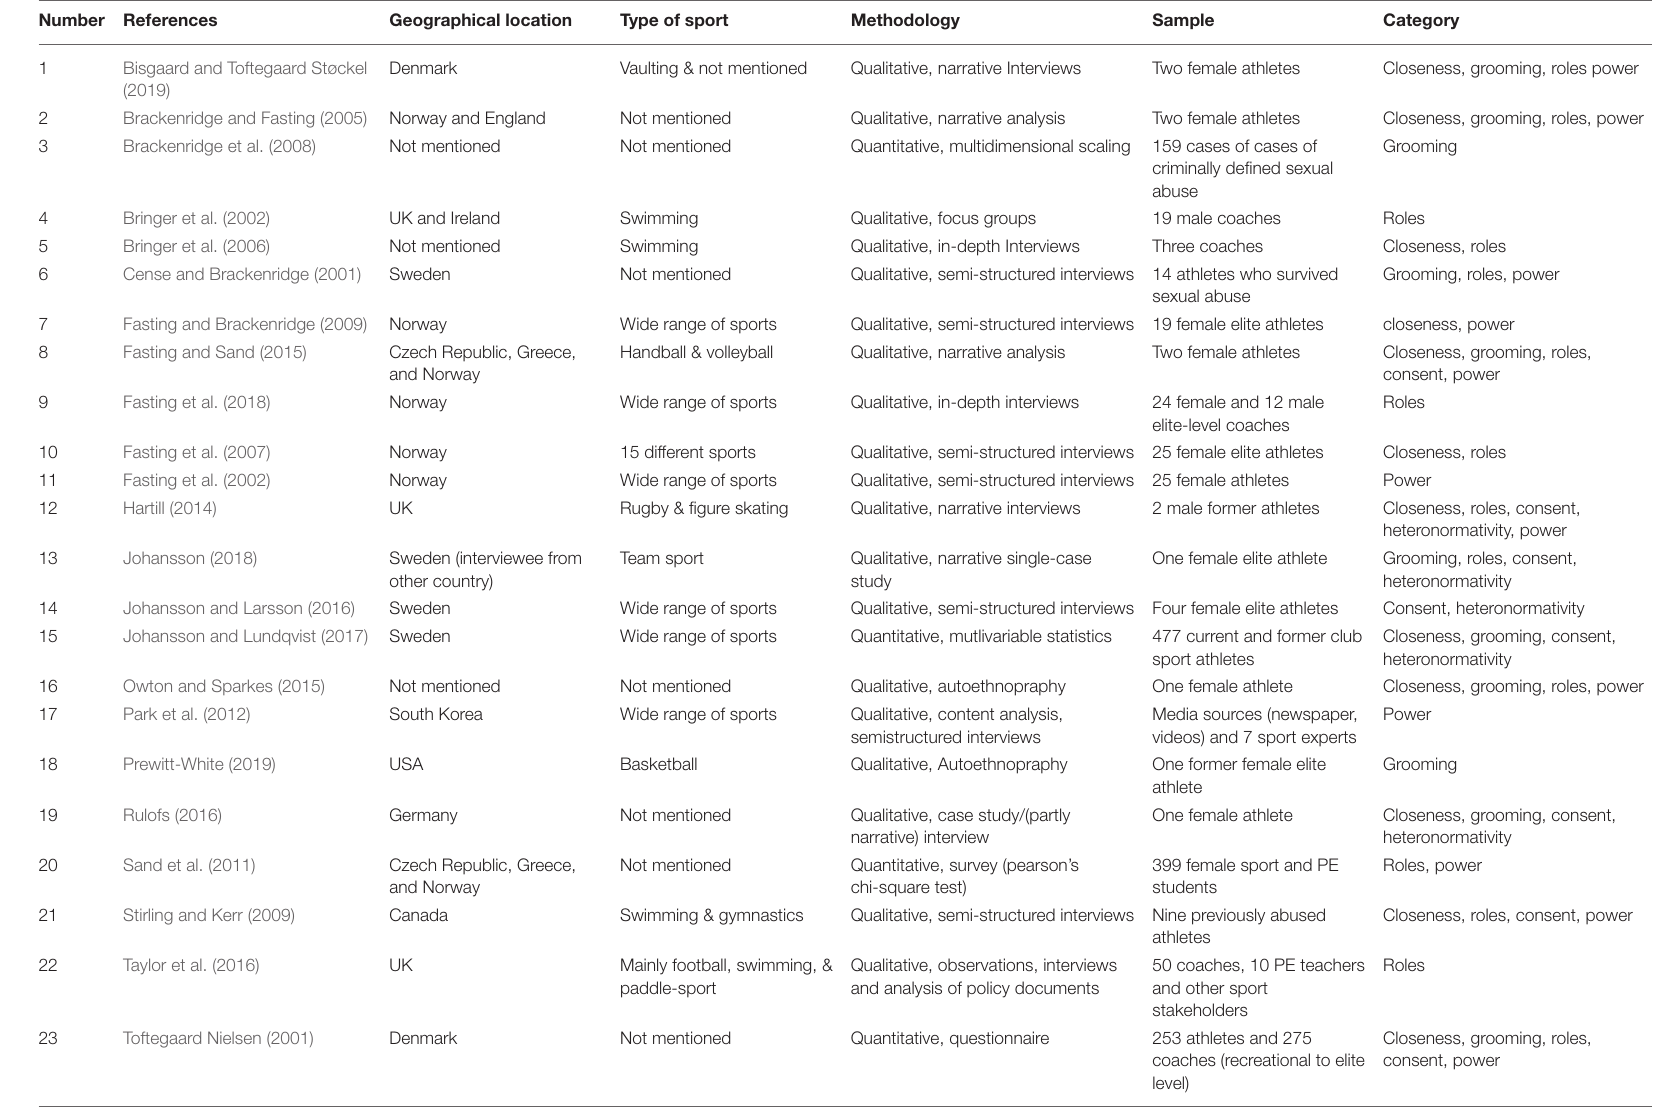
TABLE 2 | Articles with relevance to the sociological